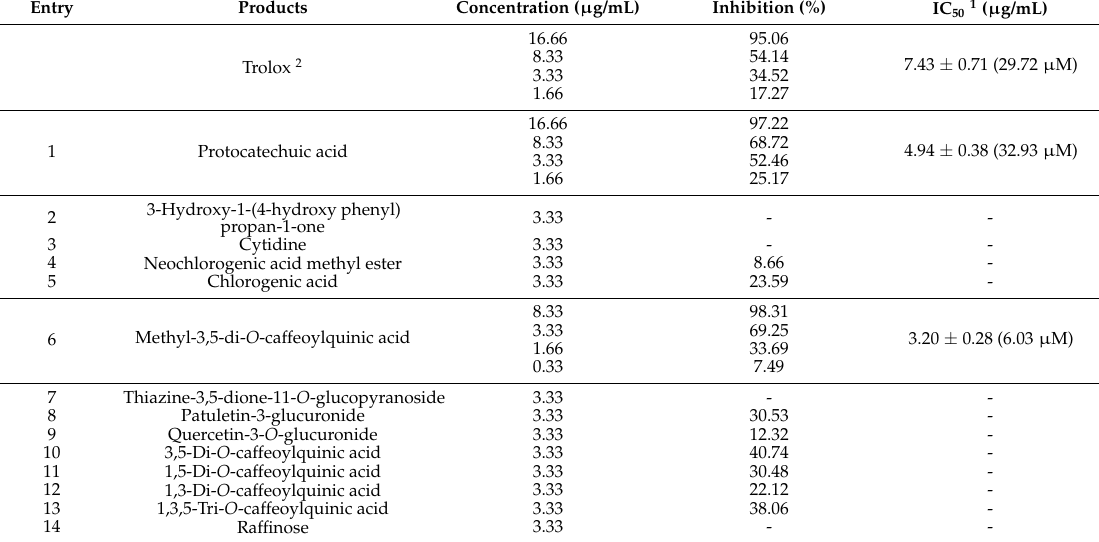
Table 6. Inhibitory effect of isolated compounds from X. strumarium on ABTS + radical scavenging